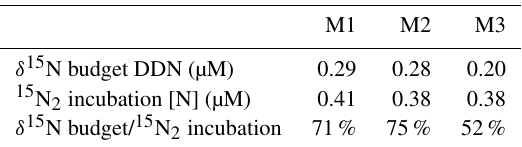
Table 2. Comparison of time-integrated diazotroph derived N (DDN) for each mesocosm based on δ 15 N budget calculations and 15 N 2 fixation incubation